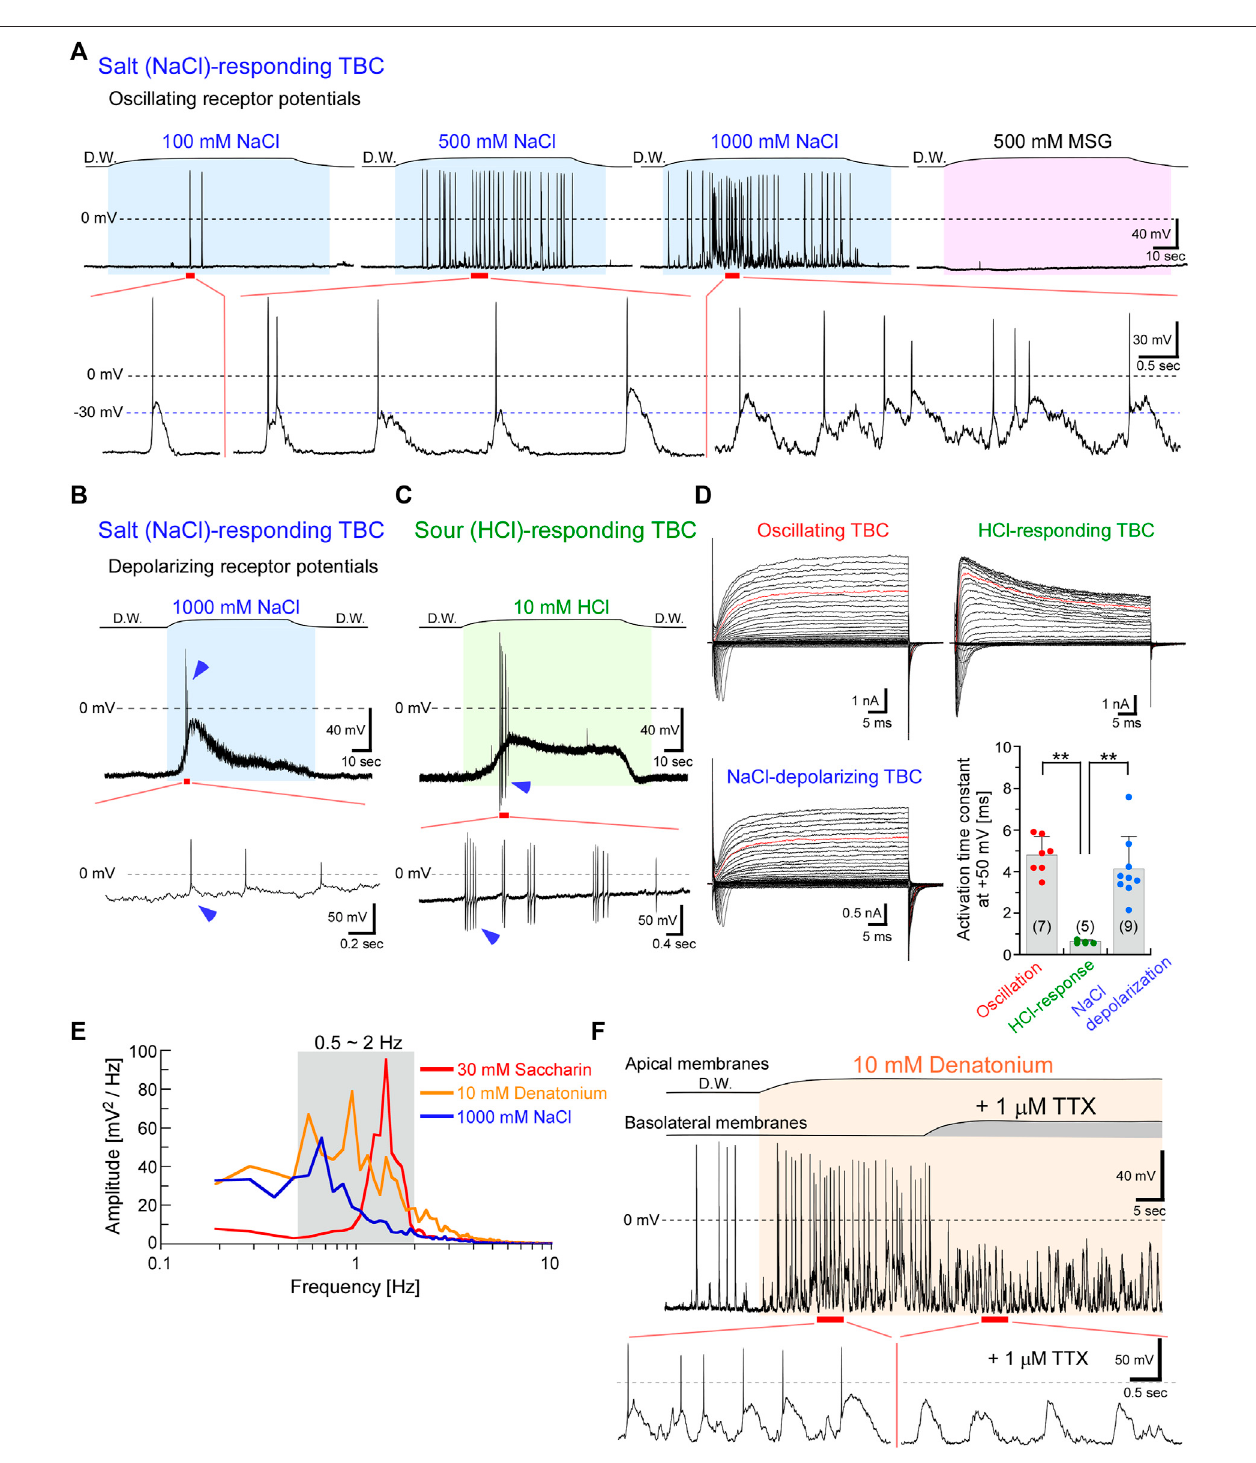
FIGURE 2 | NaCl taste stimuli induced oscillating or depolarizing receptor potentials, whereas HCl stimuli generated depolarizations in type III cells. (A) Representative oscillations responded to a series of NaCl concentrations. The frequency and magnitude of oscillations increased with increasing concentration. However, this TBC did not respond to MSG. (B) Another TBC indicated depolarization with action potentials (arrowheads) in response to 1 M NaCl. (C) Sour stimuli (10 mM HCl) also induced depolarization with action potentials and exhibited after-hyperpolarization (arrowheads). (D) A family of voltage-gated currents. The activation kinetics of the outward rectifying currents at +50 mV (red traces in each family current) was signi fi cantly faster in TBCs responding to HCl than in others (** p < 0.01; one-way analysis of variance followed by Scheffe ’ s multiple comparison test). Data are presented as means ± standard deviations. The numerals in the